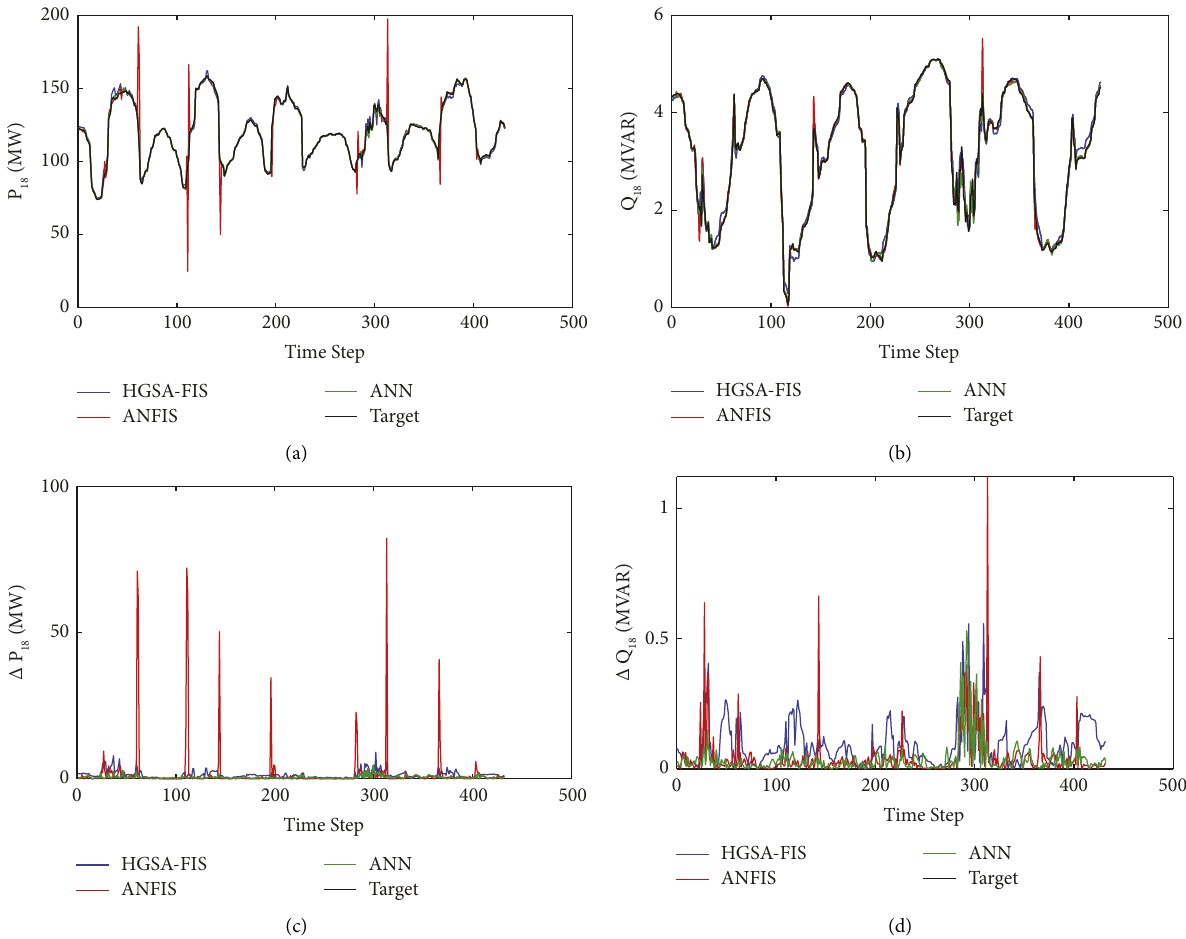
Figure 12: Comparison of prediction accuracy of HGSA-FIS, ANFIS, and ANN models in predicting tie-line L18 power flows: (a) P | , and (d) APE | Δ Q Q , (c) APE | Δ P 18 18